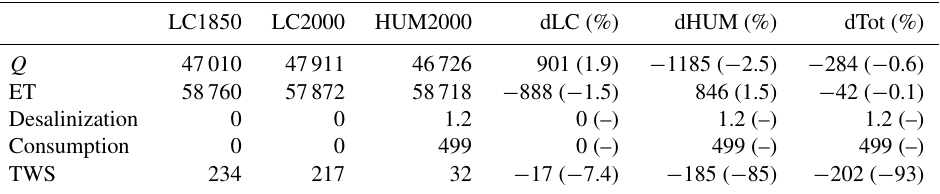
Table 4. Overview of water balance terms (inkm 3 yr − 1 ), with percentages in brackets for the last three columns except for desalinization and consumption as these are not included in LC1850 and LC2000. Q is the total global discharge. ET reflects total evapotranspiration. TWS is terrestrial water storage (including water bodies). Note that the positive values for TWS indicate a positive trend in each experiment (in km 3 yr − 1 ), reflecting a drift, and that TWS in HUM2000 is larger than in the other experiments (not evident from this table; in this case PCR-GLOBWB includes reservoirs and fossil groundwater).